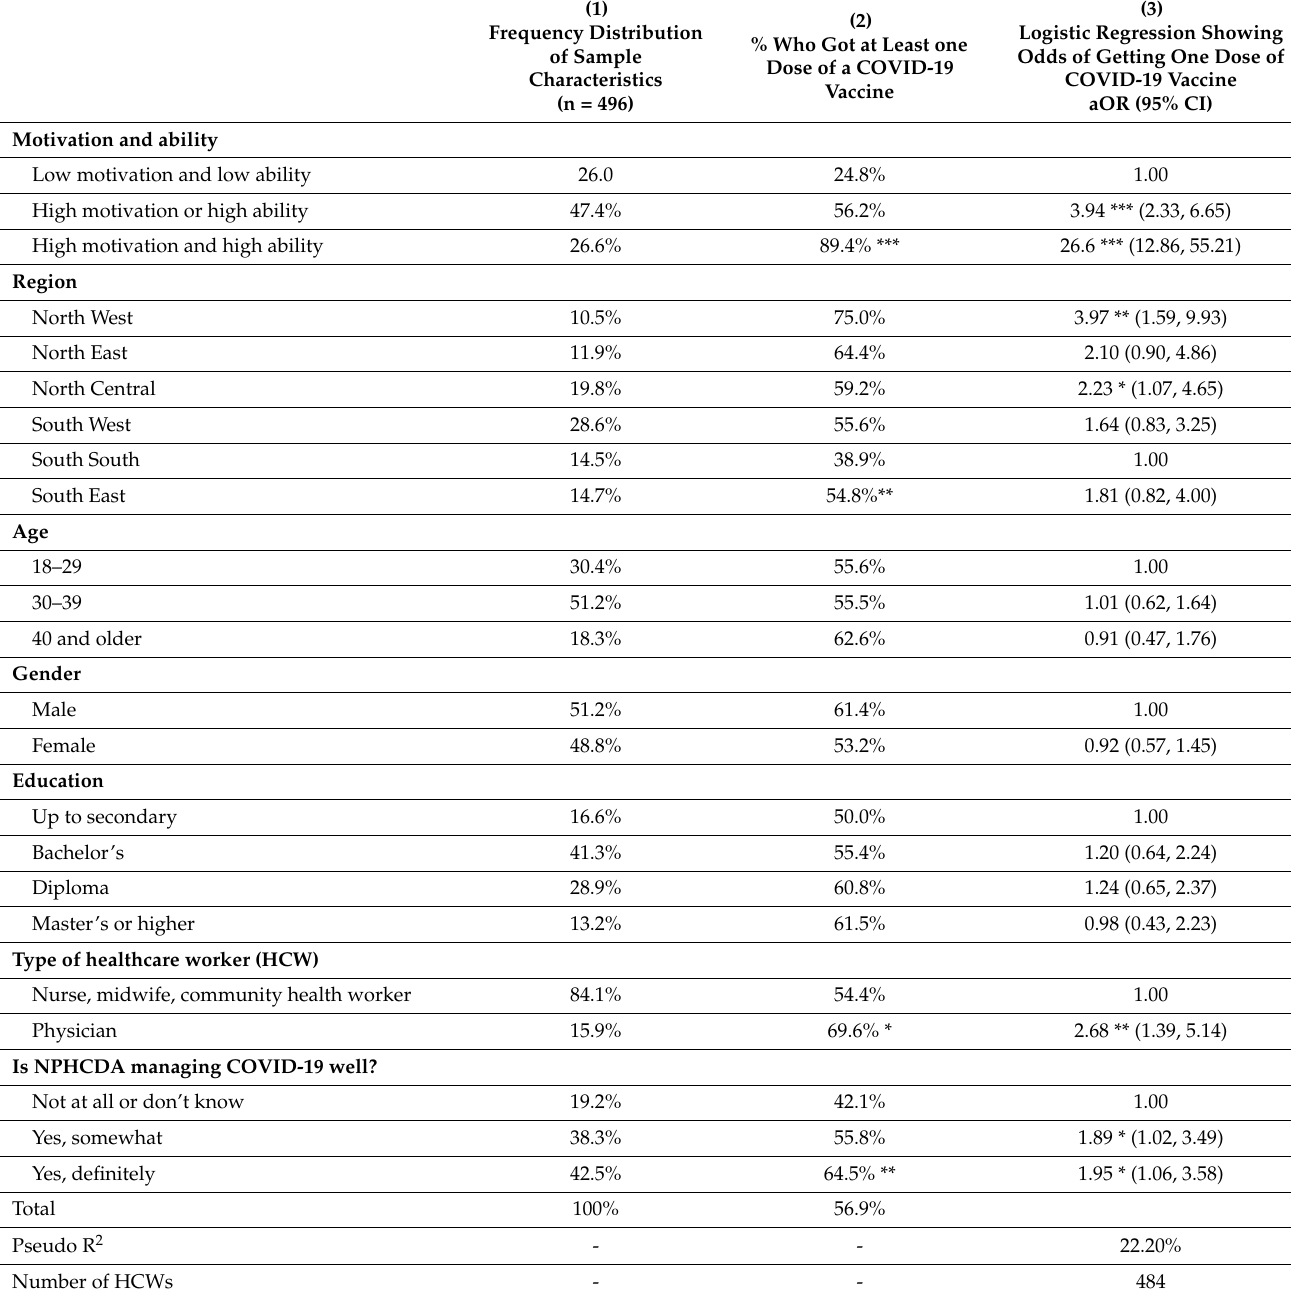
Table 3. Frequency distributions, cross tabulations and the adjusted odds of an HCW getting at least one dose of a COVID-19 vaccine,